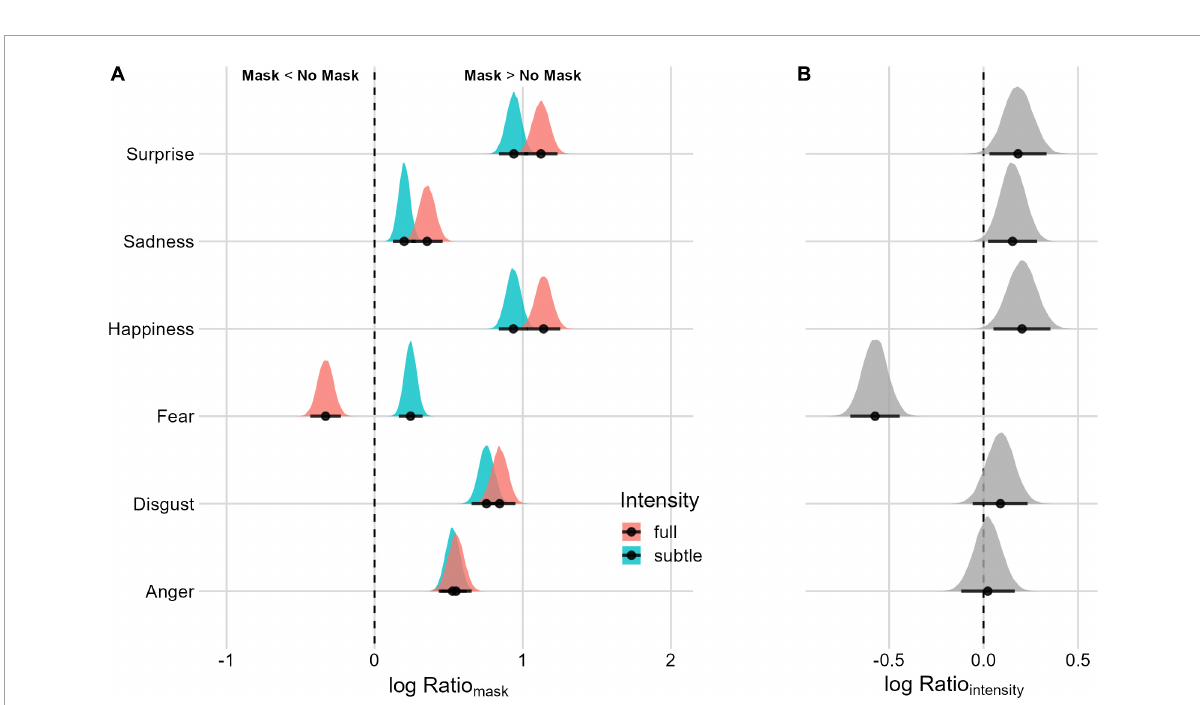
FIGURE6 Posterior distributions and 95% HPDIs of the uncertainty Facial Expression Intensity Effect (A) uncertainty posterior distributions as a function of the Facial Expression Intensity condition. (B) Posterior distribution of the Facial Expression Intensity Ratios (Mask Ratio full /Mask Ratio subtle ). Values are plotted on the logarithm scale for better visualization (the null value is